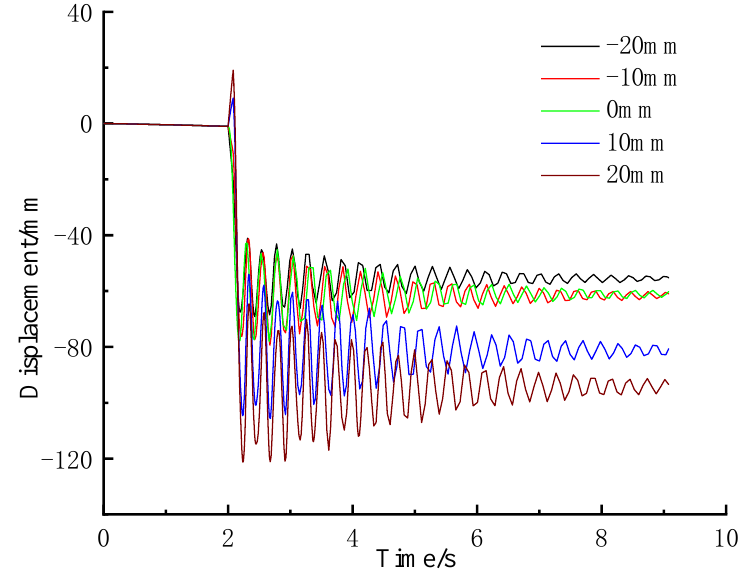
Figure 3. Effect of initial displacement.